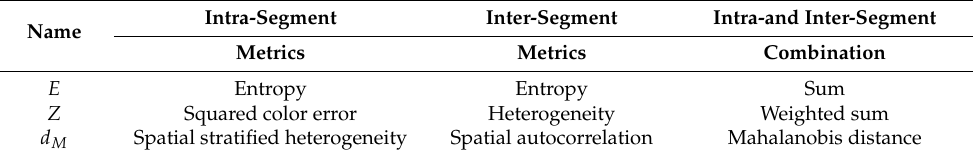
Table 1. The measures used in the existing and proposed unsupervised evaluation